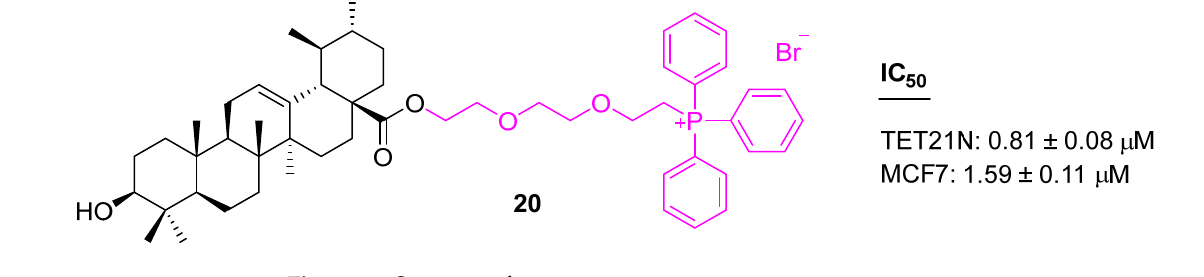
Figure 14. Structure of 20 .